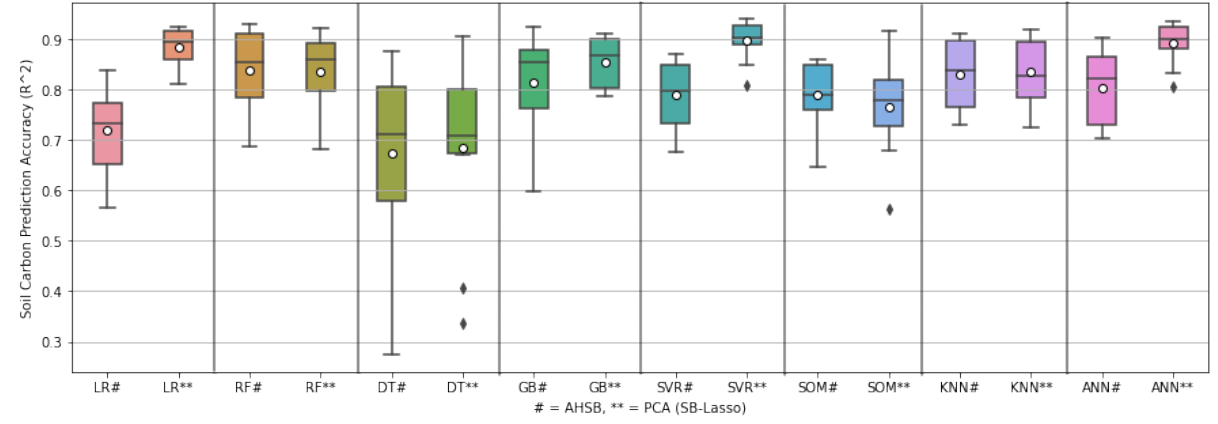
Figure 12. Box-plot of different ML approaches for predicting soil